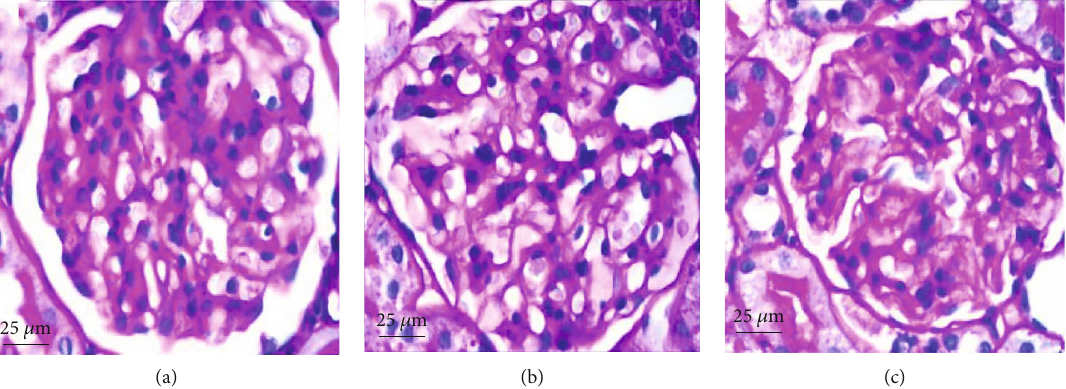
Figure 2: Histopathology of rat renal tissues. Periodic acid-Schi ff base (PAS) staining of renal tissues from the (a) NC group, (b) DM group, and (c) FK group. Magni fi cation × 400.